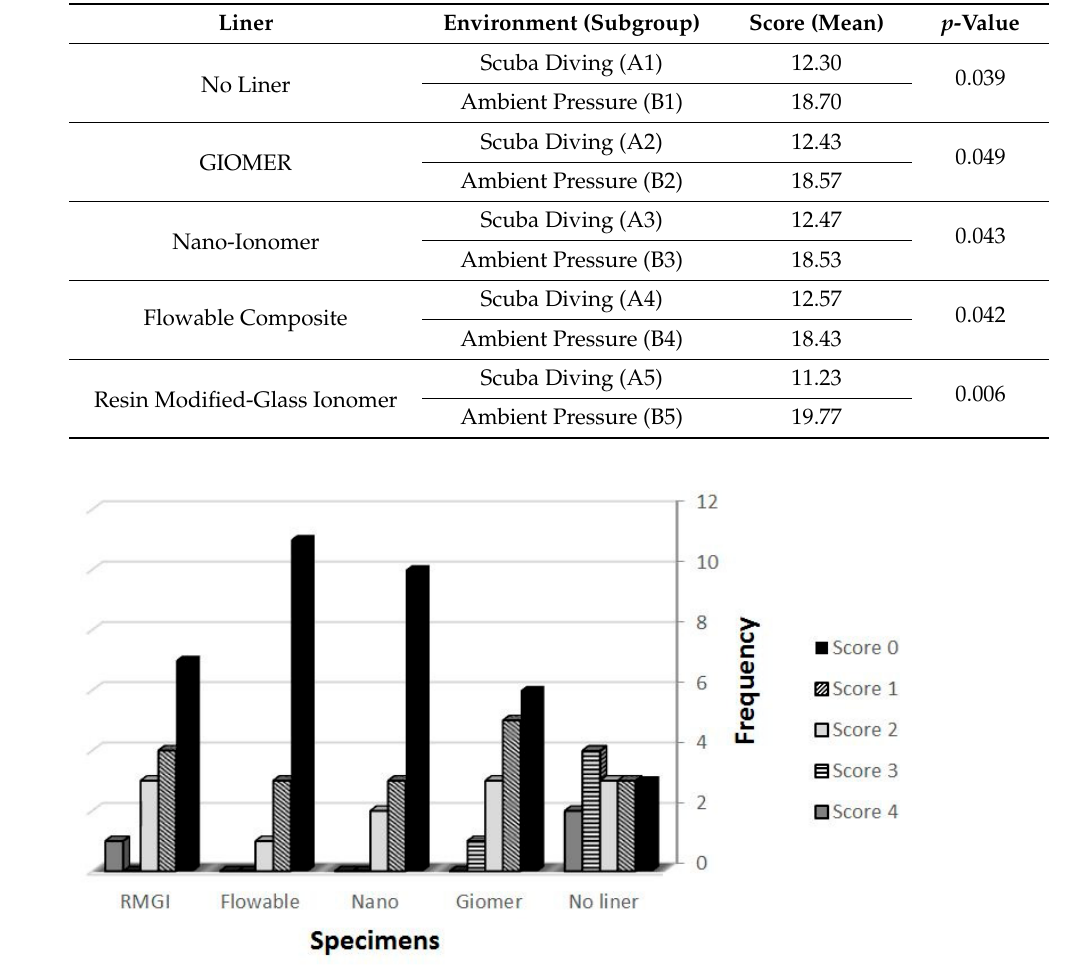
Table 1. Comparison of microleakage score between counterpart subgroups using Mann–Whitney test.